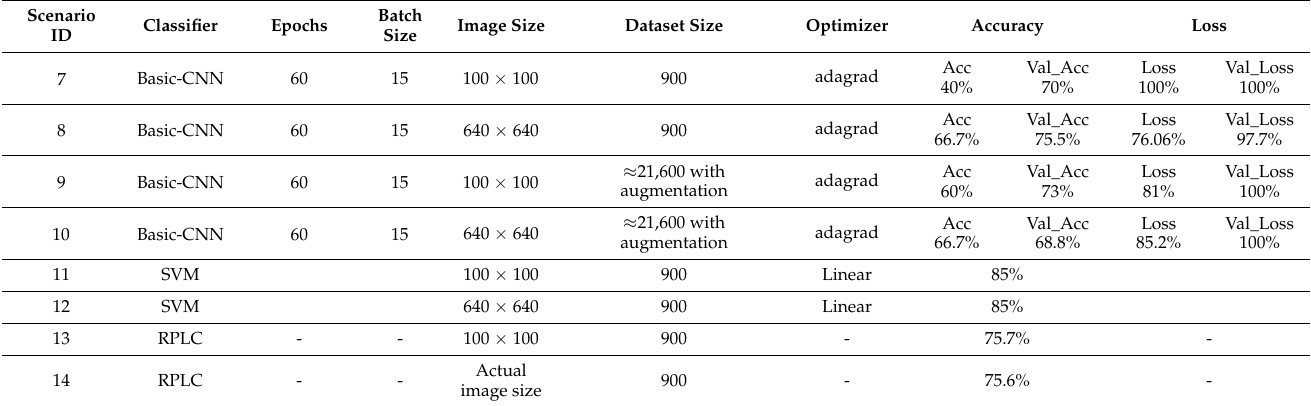
Table 3. Performance Comparison of RPLC.